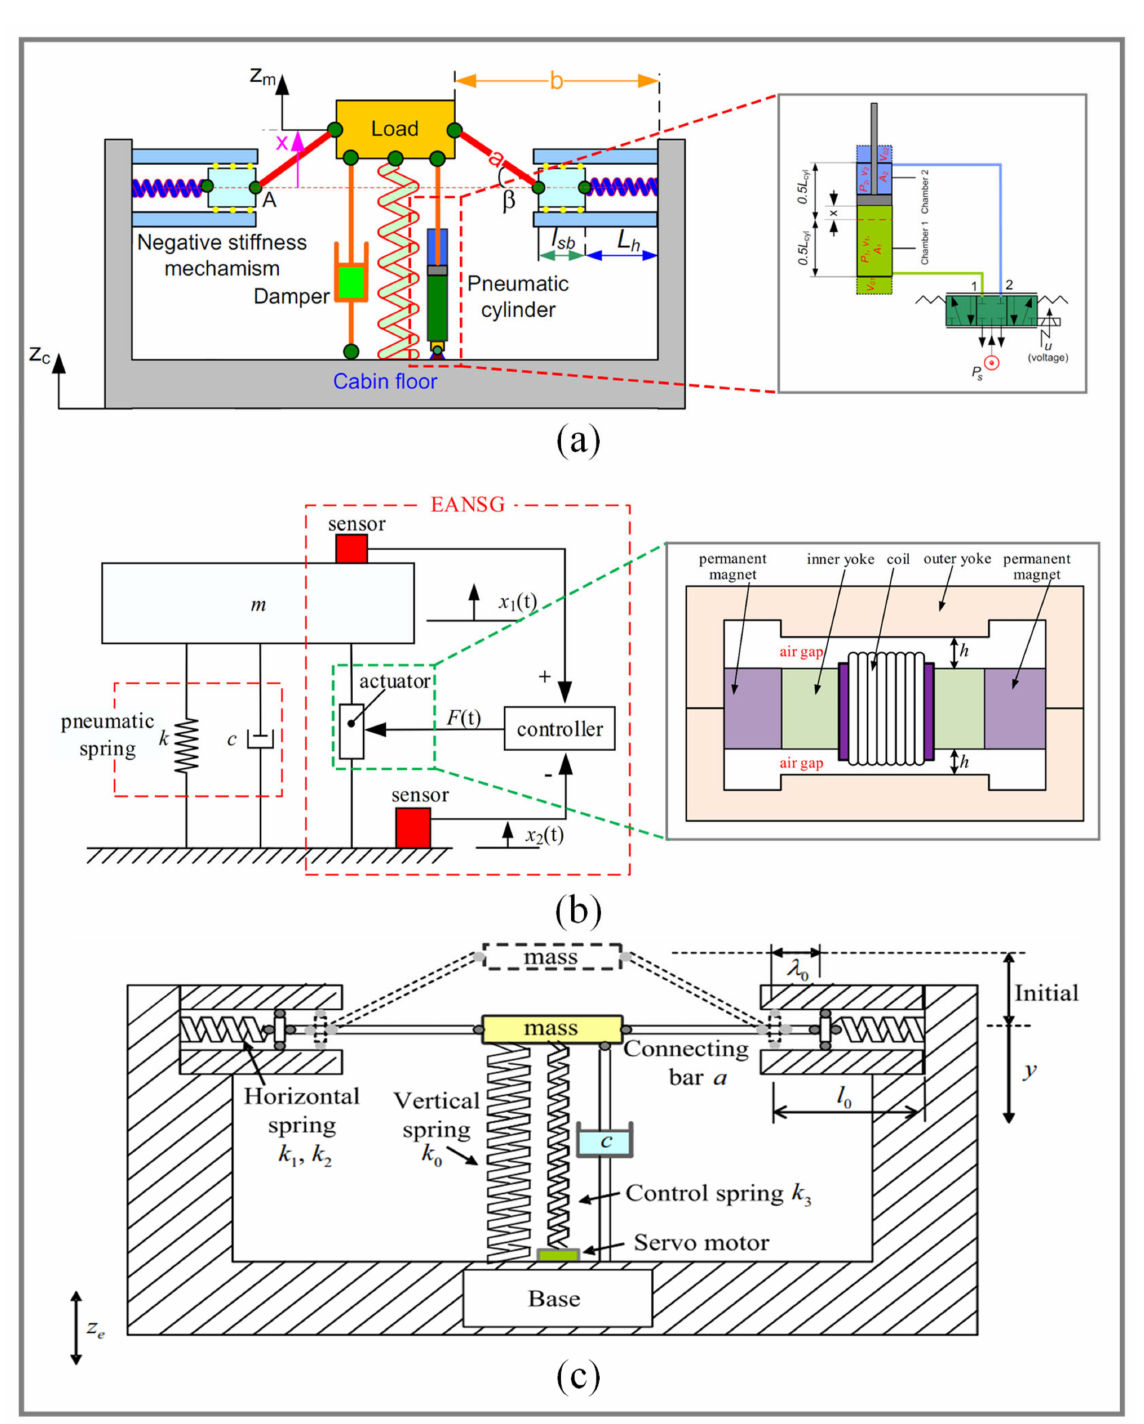
Figure 24. Active/semi-active QZS vibration isolators with the controller set outside the system: ( a ) The active pneumatic QZS vibration isolation system for low excitation frequencies proposed by Danh et al. [129]; figures adapted with permission from Ref. [129]. Copyright 2014, copyright Ahn, K.K.; ( b ) The electromagnetic active-negative-stiffness generator proposed by Zhao et al. [131]. ( c ) A time-delayed active control strategy to improve the performance of a quasi-zero-stiffness vibration isolator is provided in Ref. [124]. Figures adapted with permission from Ref. [124]. Copyright 2014, copyright Sun,